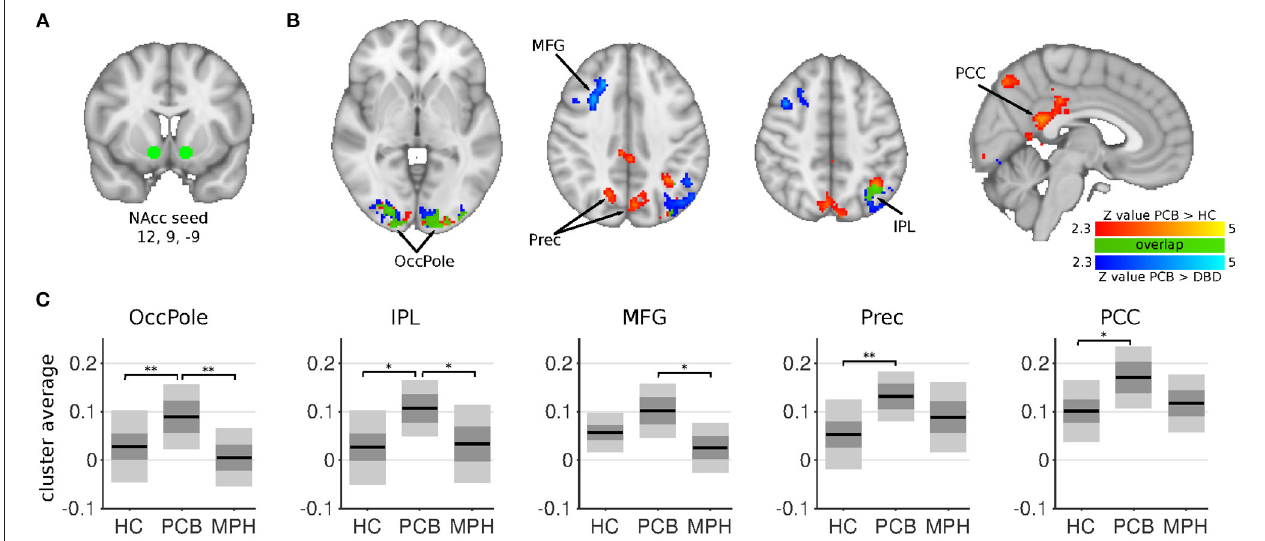
FIGURE 1 | NAcc connectivity differences between HC, DBD-PCB, and DBD-MPH groups. (A) Location of the NAcc seed. (B) Clusters showing significant connectivity differences ( Z > 2.3, cluster p < 0.05). (C) Average Fisher- Z transformed NAcc connectivity in the significant clusters. Dark gray patches represent the 95% confidence interval and light gray patches represent the standard deviations. Black lines represent the group means. All shown coordinates are in MNI space. NAcc, nucleus accumbens; OccPole, Occipital pole; Prec, Precuneus; MFG, medial frontal gyrus; IPL, inferior parietal lobule; PCC, posterior cingulate cortex; HC, healthy control; PCB, placebo; MPH, methylphenidate; *cluster- p < 0.05; **cluster p <